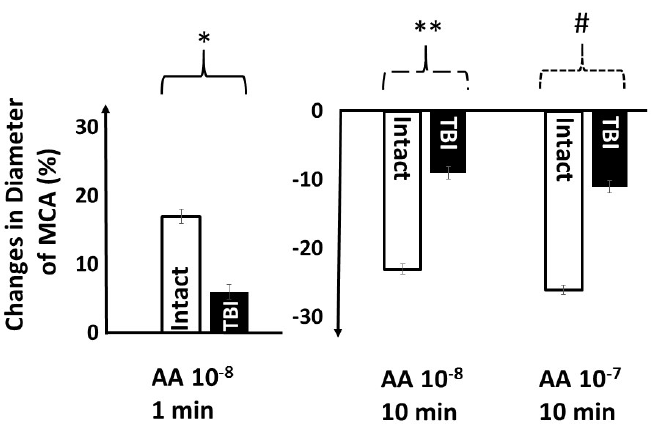
Figure 3. In middle cerebral arteries (MCAs) isolated from intact rats, lower concentration of ara- chidonic acid (AA), after initial dilations, ( left panel), elicited constrictions ( right panel), whereas higher concentration of AA elicited only constriction. After traumatic brain injury (TBI), AA-in- duced responses were significantly reduced. Data are mean ± SEM of normalized diameter %. (*, **, # indicate p < 0.05).